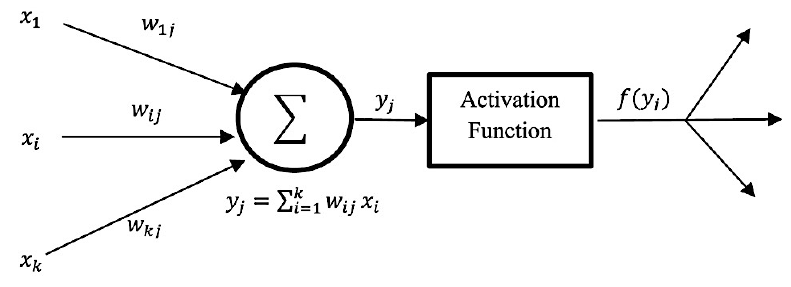
Figure 11. Basic structure of feed-forward ANN [127].